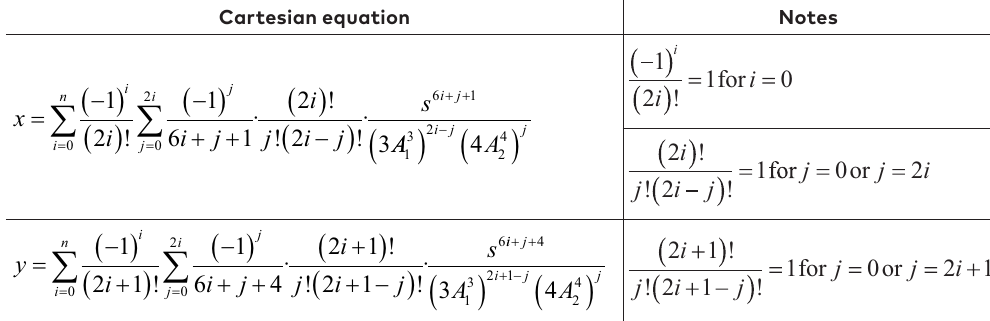
Table 4. The Cartesian equation of the Bloss curve (biparametric or bi-hyperclothoid curve) Cartesian